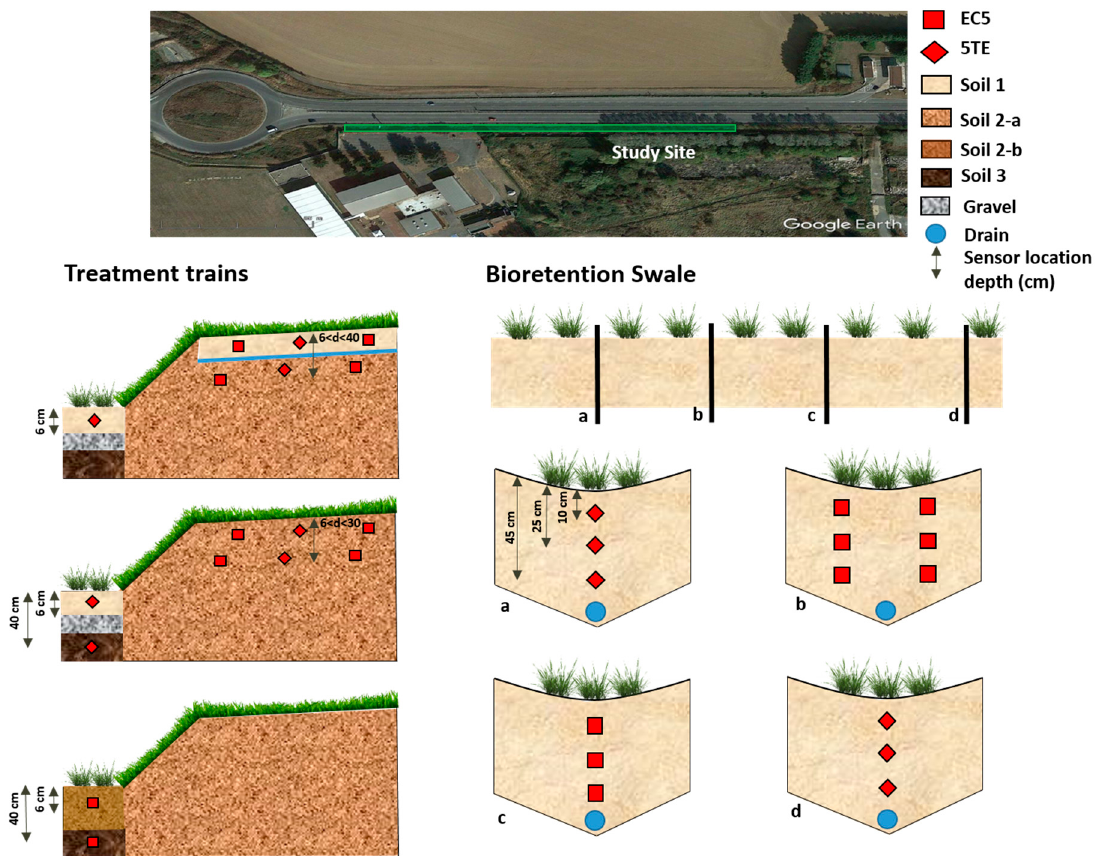
Figure 1. At the top a google earth photo of the studied site including the treatment trains and bioretention swale represented by a green rectangle. A schematic depiction (not to scale) of three treatment trains cross-sections is represented below the photo. A longitudinal section of the bioretention swale in addition to four cross-sections are also illustrated. The location and the installation depth of soil moisture sensors, the EC5 and 5TE, are indicated.